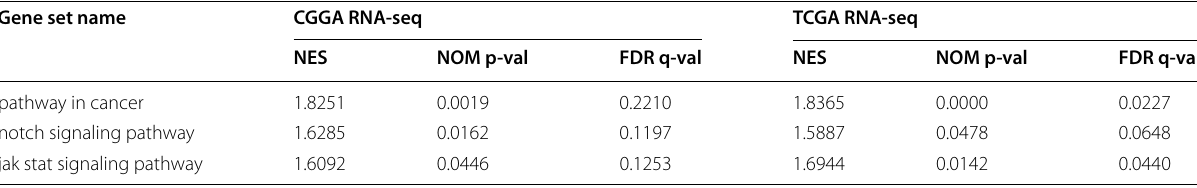
Gene sets with NOM p-value < 0.05 and FDR q-value < 0.25 were considered as significantly enriched NES normalized enrichment score; NOM nominal; FDR false discovery